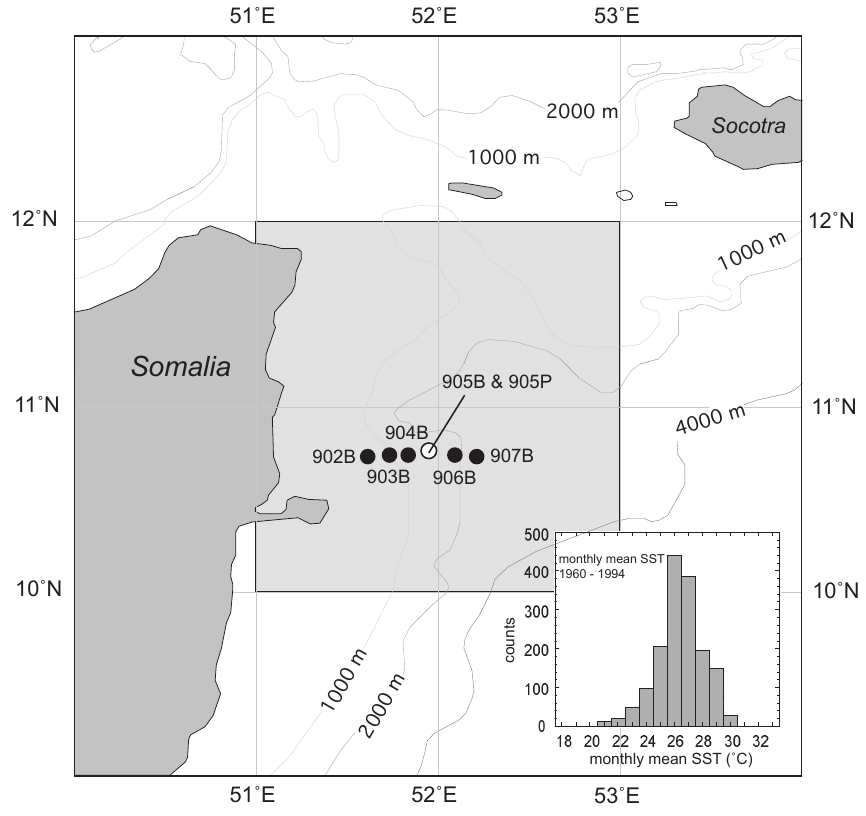
Fig. 1. Core locations of box cores 902 to 907 and piston core 905P. The histogram shows the distribution of modern monthly mean sea surface temperatures from the area indicated in grey. The modern temperatures used for the validation of the approach are monthly mean sea-surface temperatures between 1960 and 1994 (1993 was the year of the sediment sampling). Please note that temperatures range from 18.8 to 33.0 ◦